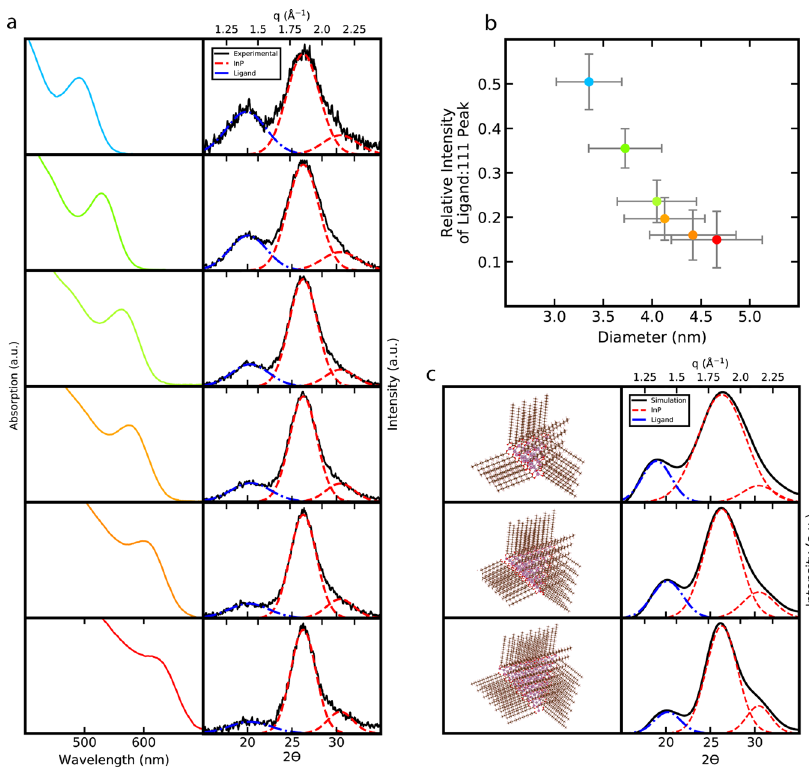
Fig. 2 Experimental and simulated powder X-ray diffraction spectra of a size series of indium phosphide quantum dots determined by absorption spectra. a Absorption spectra of indium phosphide quantum dots indicating the size of the quantum dots coupled with the powder X-ray diffraction spectra. b Relative intensity of the ligand peak to the (111) diffraction peak of indium phosphide as a function of quantum dot size determined by powder X- ray diffraction peak deconvolution. Error in relative intensity was determined by propagation of the standard error in counts per second from the detector and error in nanocrystal size was taken at 10% from reported errors in sizing calculation functions determined by UV – Vis spectroscopy (see “ Methods ” section). c Atomic models of a size series of indium phosphide quantum dots and the corresponding simulated powder X-ray diffraction patterns. Cu K- α ð λ ¼ 1 : 5418 Å Þ is the X-ray source for all experimental and simulated powder X-ray diffraction